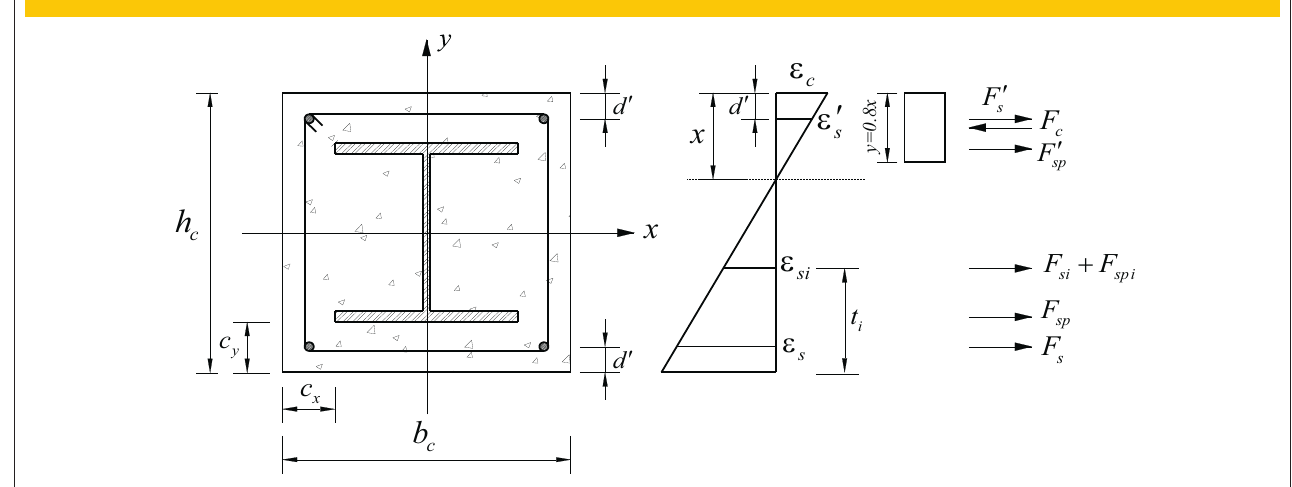
Figure 4 – Composite section and strain diagram with scheme of resultant